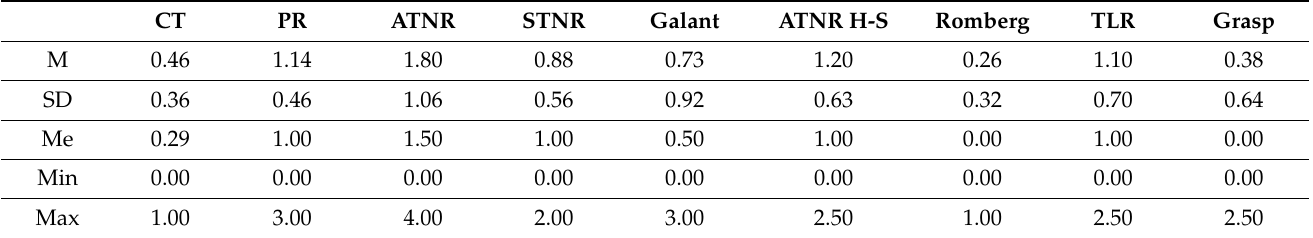
Table 1. Descriptive statistics obtained in the examination of the level of reflexes and clock test performance.